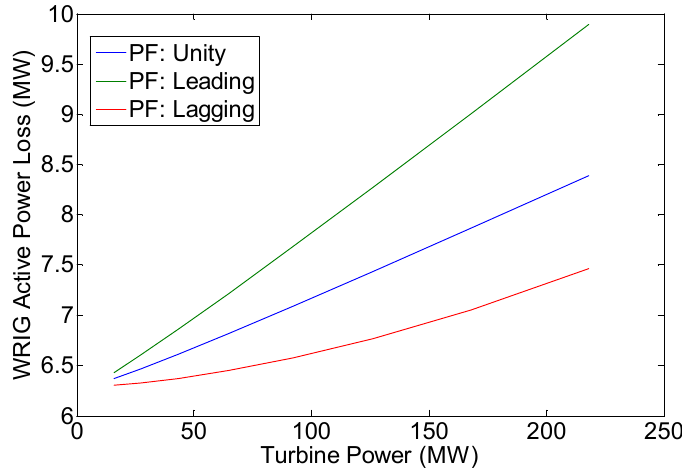
Figure 7. Variation of WRIG rotor power ( P R ).